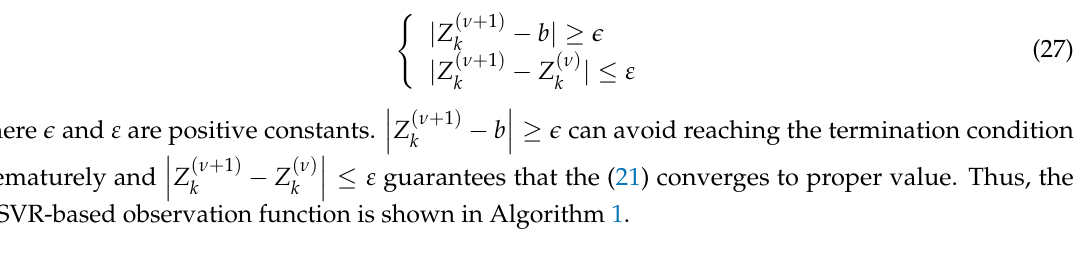
Algorithm 1 LSSVR-based observation